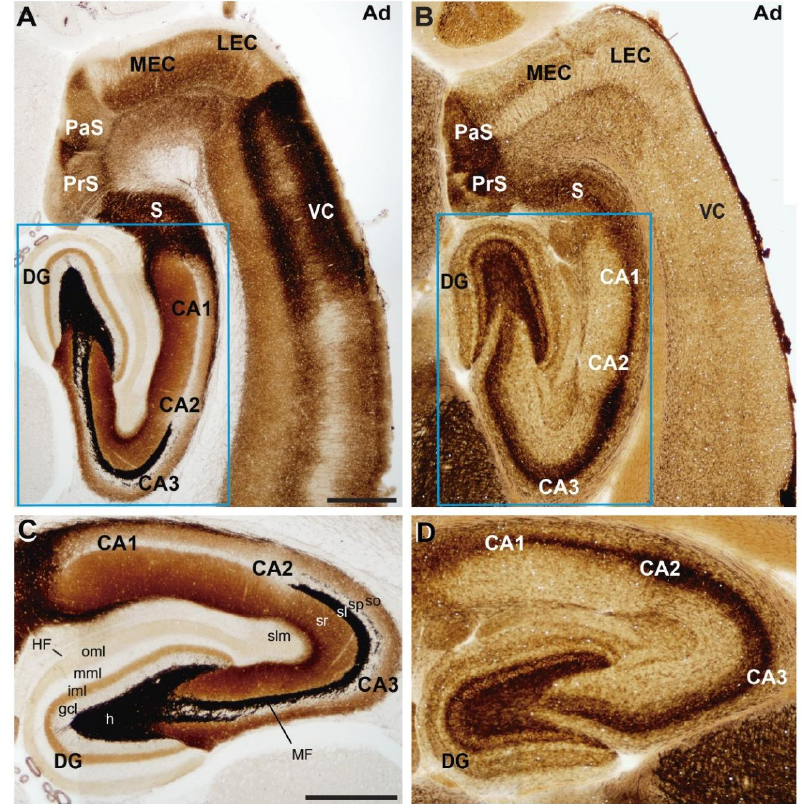
Figure 1. Anatomical organization of the rat hippocampal formation. Photomicrographs illustrating the pattern of ( A , C ) selenite-silver staining (TIMM) and ( B , D ) acetylcholinesterase reaction in horizontal sections of adult rats. Both stainings illustrate the distribution of the main regions and layers of the hippocampal formation. A higher magnification of the blue boxed area in ( A , B ) is shown in ( C , D ) respectively. Abbreviations: CA1–3 = cornus ammonis region 1–3; DG = dentate gyrus; gcl = granule cell layer; h = hilus; HF = hippocampal fissure; iml = inner molecular layer; LEC = lateral entorhinal cortex; MEC = medial entorhinal cortex; MF = mossy fiber bundle; mml = medial molecular layer; oml = outer molecular layer; PaS = parasubiculum; PrS = presubiculum; S = subiculum; sl = stratum lucidum; slm = stratum lacunosum-moleculare; so = stratum oriens; sp = stratum pyramidale; sr = stratum radiatum; VC = ventrolateral neocortex. Scale bars: A = 500 µ m pertains to (B); C = 500 µ m pertains to